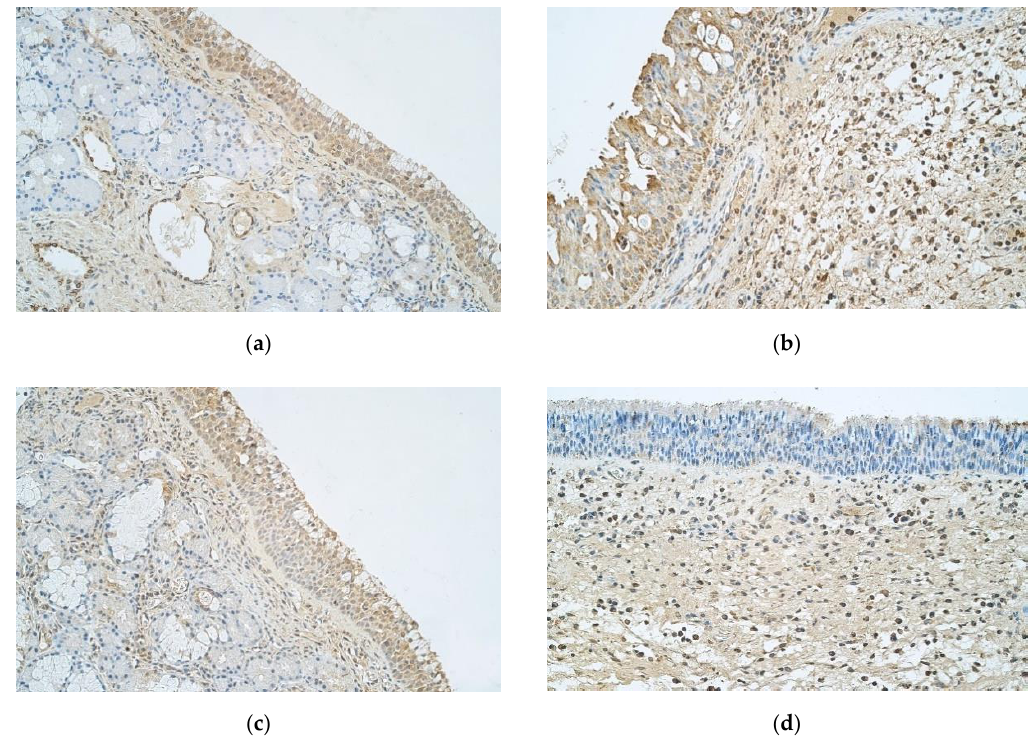
Figure 3. ( a – d ) Immunohistochemical micrographs of inpatients with nasal polyps and control subjects. ( a ) 42-year-old male with healthy nasal mucosa. Numerous IL-6 positive structures in the control sample epithelium and few positive structures in connective tissue. IL-6 IMH, X 250; ( b ) 30-year-old female with CRSwNP. Few to moderate IL-6 positive structures in epithelium and moderate to numerous IL-6 positive structures in connective tissue of a nasal polyp. IL-6 IMH, X 250; ( c ) 42-year-old male with healthy nasal mucosa. Numerous IL-7 positive structures in epithelium of a control sample with few to moderate positive structures in connective tissue. IL-7 IMH, X 250; ( d ) 33-year-old male with CRSwNP. Few to moderate positive structures in epithelium and moderate to numerous IL-7 positive structures in the connective tissue of a nasal polyp. IL-7 IMH, X 250.